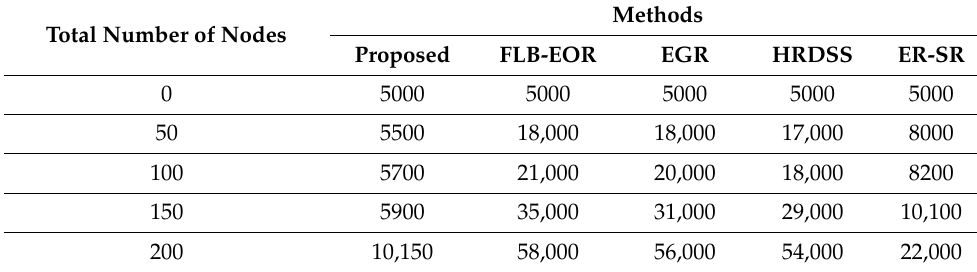
Figure 8. Comparative analysis of routing overhead. Table 7. Comparative results based on routing overhead.